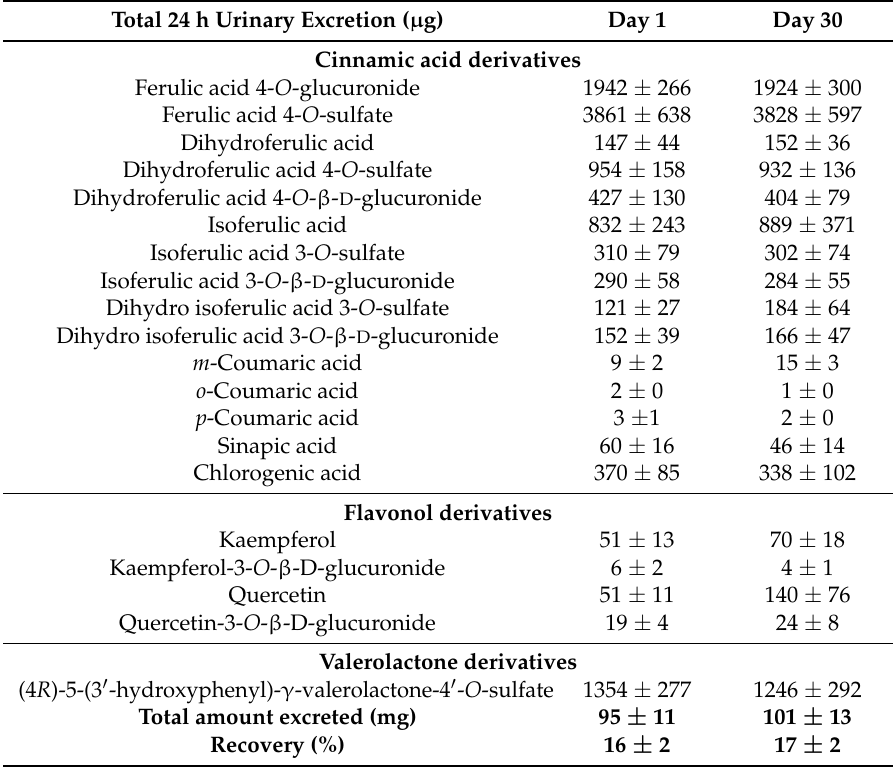
Figure 4. Total (poly)phenols concentration (µM) at 0 h after daily consumption of wild blueberries for 30 days ( n = 18). The 24 h total (poly)phenol urinary excretion values were calculated for both days 1 and 30 (Table 3). The CV% was 47% and 54% for days 1 and 30, respectively (Table 3). The recovery of (poly)phenols in urine also registered considerable large inter-individual variability. At day 1 the urinary recovery rates varied between 4% and 25%, while these values ranged from 2% to 41% at day 30. Interindividual variability was also assessed in terms of classes of (poly)phenols. Catechols and benzoic acids showed the lowest inter-individual variability in plasma (36%–58% and 50%–63%, respectively), whereas in urine benzaldehydes, phenylacetic and benzoic acids were the compounds excreted with less variability (47%–69%, 50%–54% and 40%–71%, respectively) (Table 4). Propionic acids, pyrogallols, and valerolactones were the (poly)phenols with the highest inter-individual variability, either in plasma or urine. As far as the sum of (poly)phenols detected in either plasma or excreted in urine is concerned, the inter-individual variability was lower in plasma (40%–48%) than in urine (47%–54%).